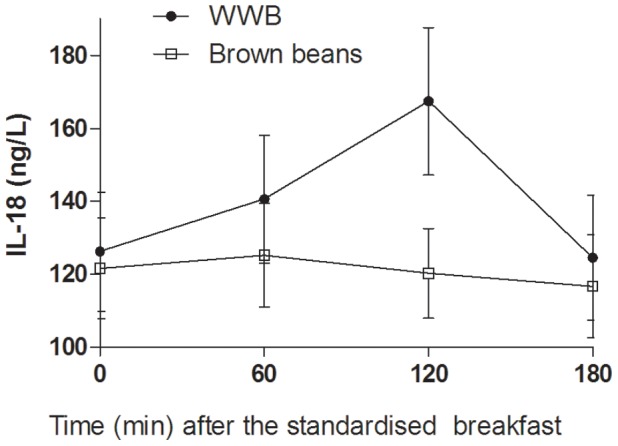
Concentrations of serum IL-18 fasting and after a standardized breakfast, consumed 11 hours after evening meals composed of brown beans or WWB.A significant treatment effect (type of evening meal) and treatment*time interaction were found over the test period (p<0.05 and p<0.001, respectively, PROC MIXED in SAS release 9.2; SAS Institute Inc, Cary, NC). n = 16 subjects.